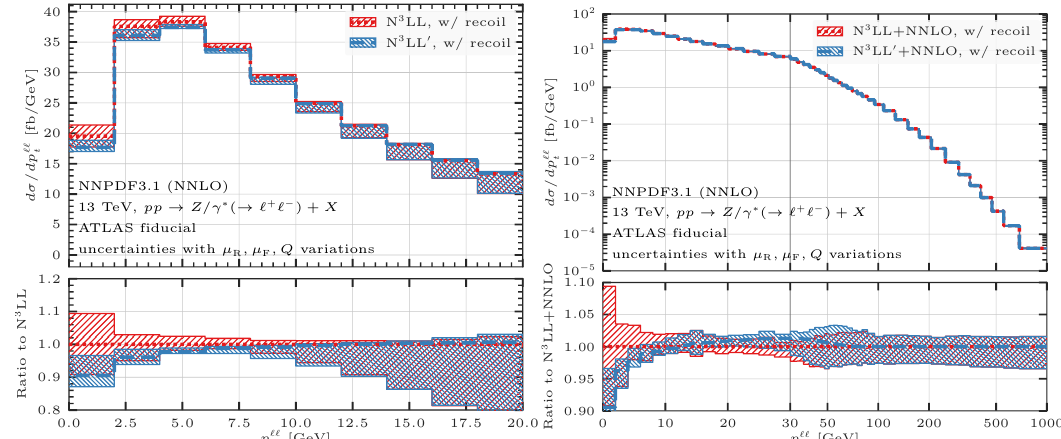
Figure 2 . N 3 LL 0 (left) and N 3 LL 0 +NNLO (right) p ‘‘ (blue) and without (purple) recoil effects. In the right plot, the x axis is linear up to 30 GeV and logarithmic above.